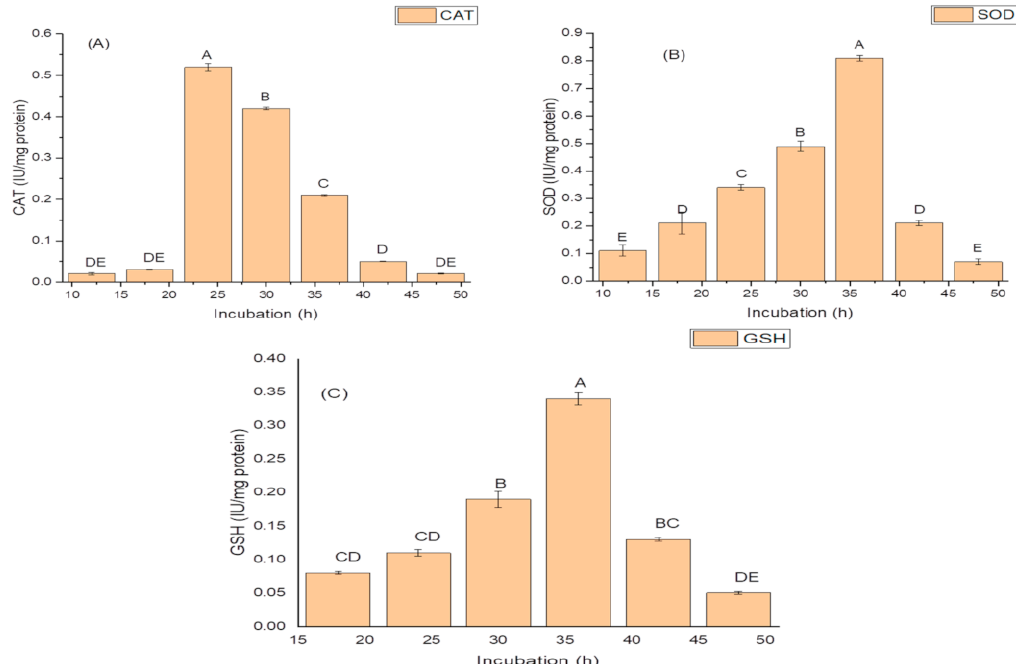
Figure 2. Effect of the incubation period on ( A ) catalase (CAT) activity; ( B ) superoxide dismutase (SOD) activity; and ( C ) glutathione reductase (GSH) activity of K. variicola SURYA6. Values are the average of five replicates and were analyzed by one-way ANOVA followed by Turkey’s test. Different letters on mean value of each parameter indicate significant differences at p <